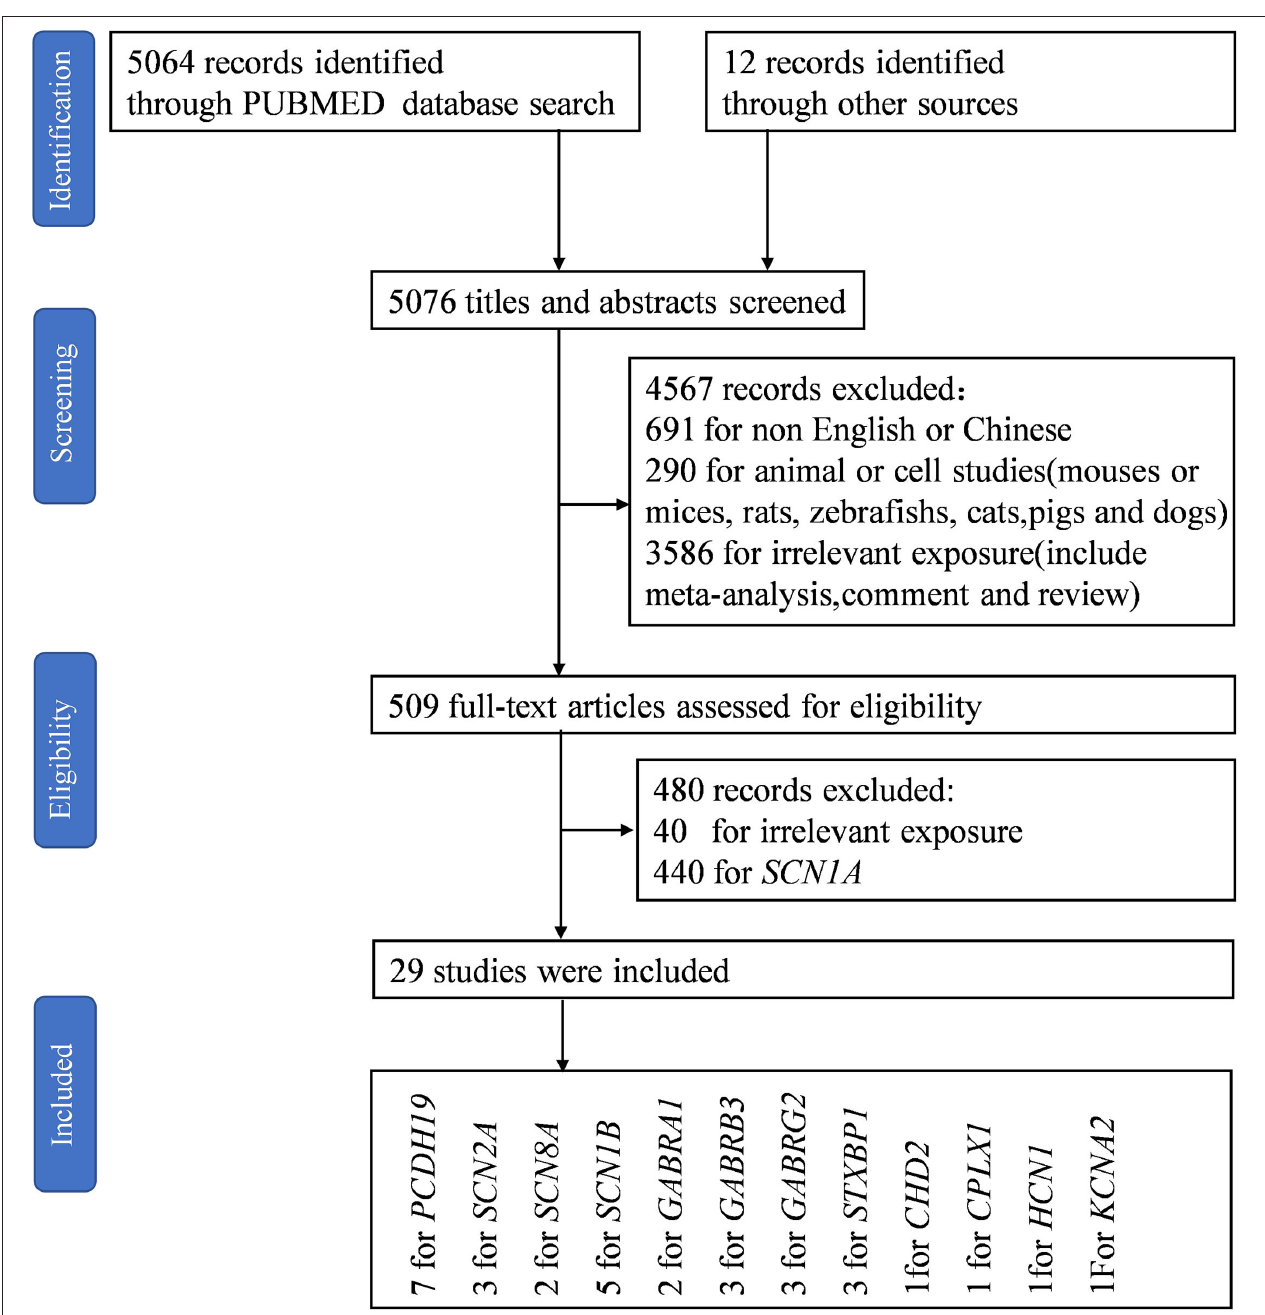
FIGURE 1 | Flow diagram of included studies. “P CDH19 , SCN8A , and STXBP1 ” and “ GABRA1 and STXBP1 ” appeared in the same study, respectively (27, 28). Liu et al. reported the same epilepsy gene in two papers (29, 30).